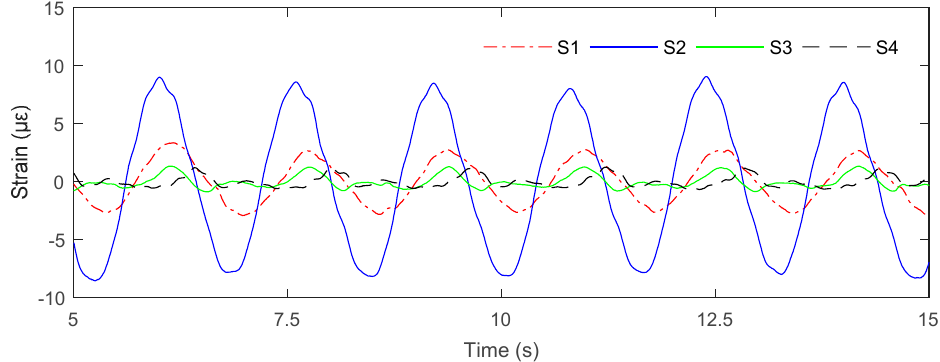
Figure 6. Time-series of the strain response of strain gauges at measurement position S5 in waves. Wave condition: H = 0.10 m and T = 1.6 s.